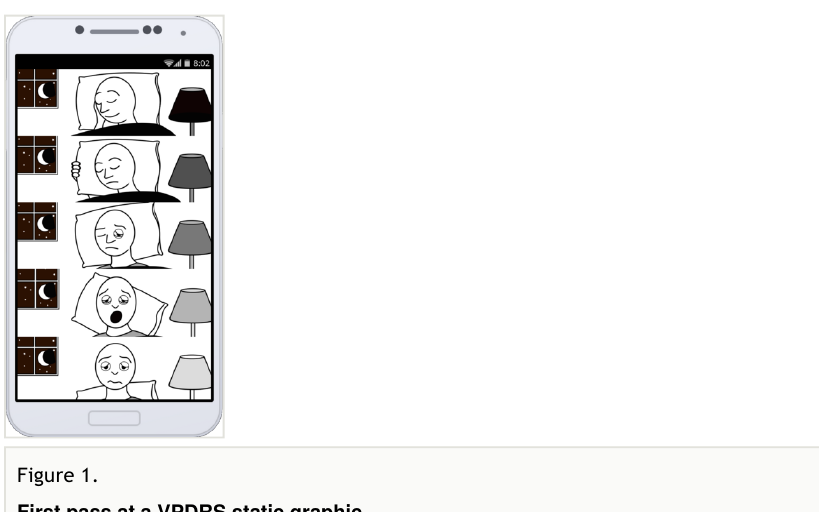
First pass at a VPDRS static graphic Figure 1 corresponds to the fi rst self-administered MDS-UPDRS question: 1.7 SLEEP